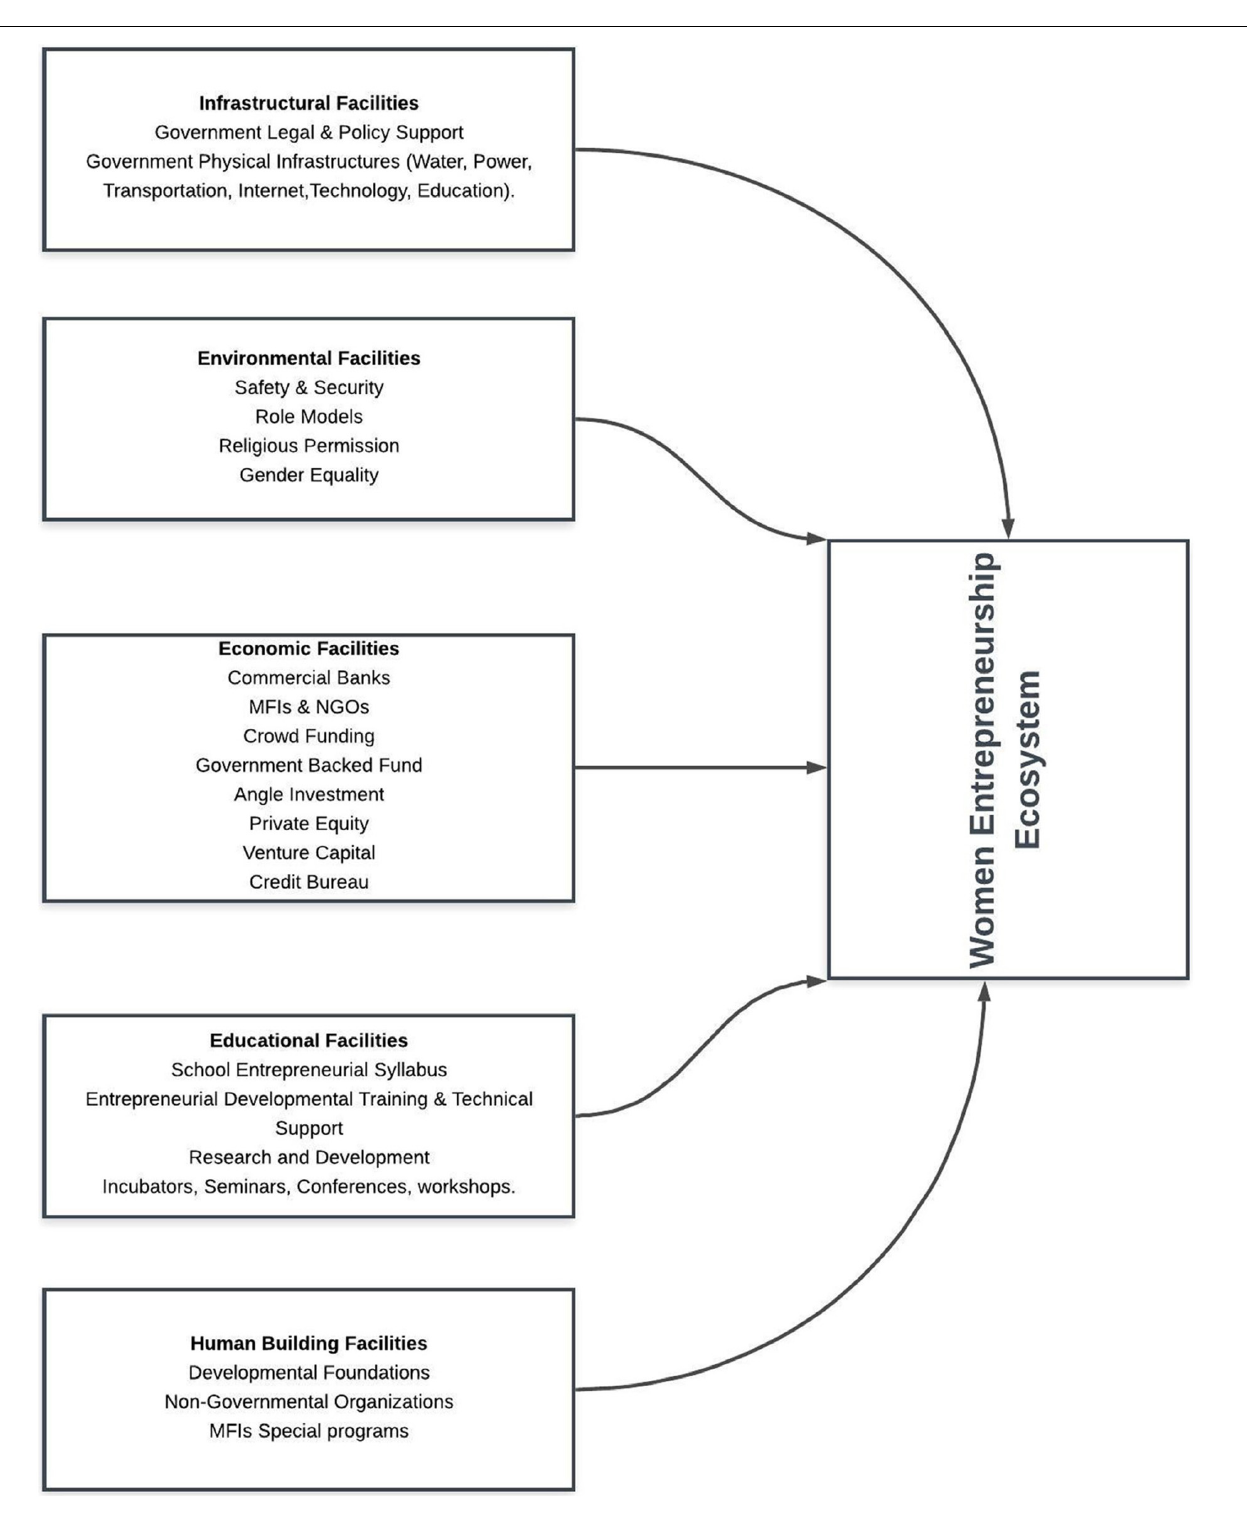
Frontiers in Education |